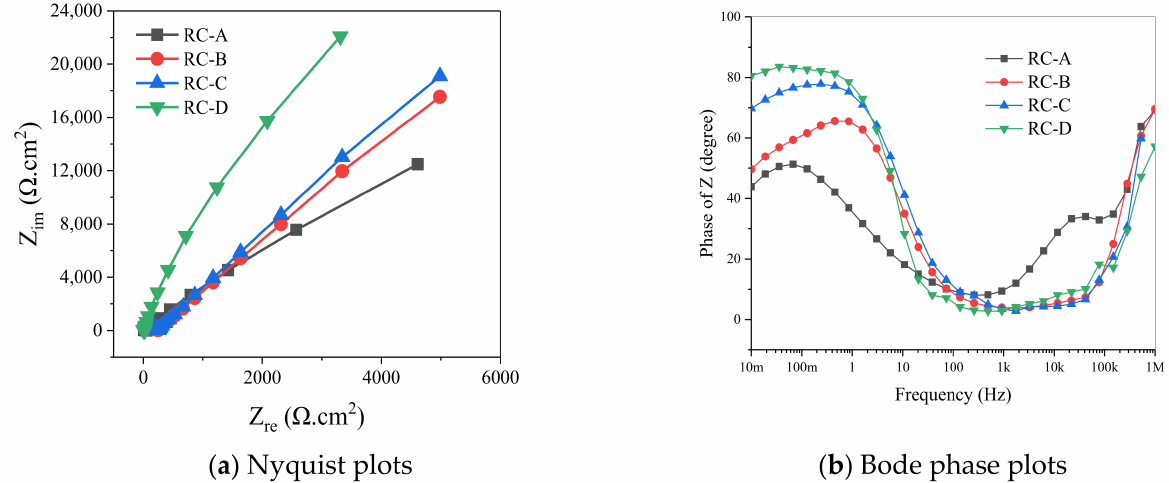
Figure 5. EIS of rusty steel electrodes treated with RC-A, RC-B, RC-C, and RC-D.